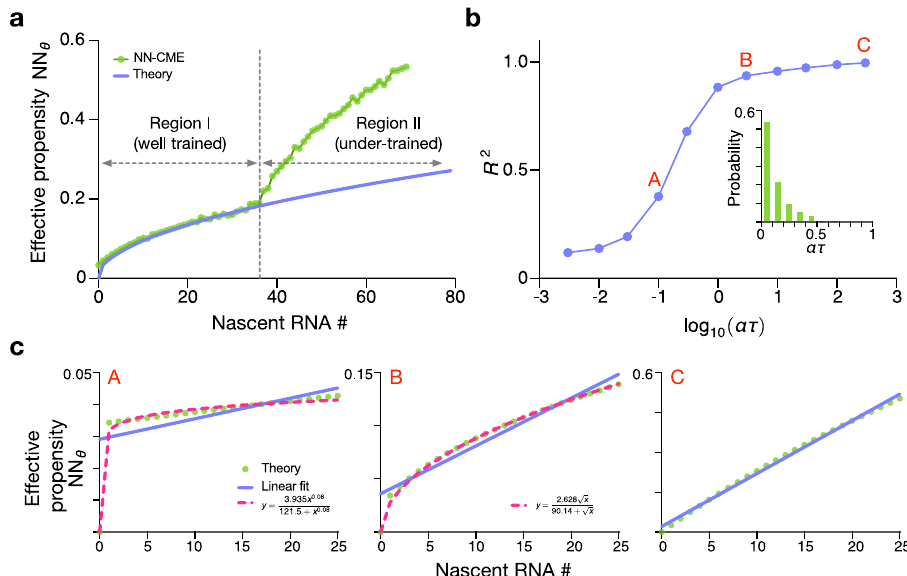
Fig. 4 Effective degradation propensity of Model II. a Comparison of the effective degradation propensity NN θ ( n ) in steady-state conditions predicted by theory (solid purple line; Eq. S36 in the SI) and computed by the ANN-aided approximation (green dots). Note that the two agree in Region I where the nascent RNA probability is suf fi ciently high so that the neural-network coef fi cients are well-trained. The two are not matched in Region II, since the neural- network coef fi cients are under trained such that the neural-network output is not reliable. b Shows the square of the Pearson correlation coef fi cient R 2 between the effective propensity and the nascent RNA number as a function of the non-dimensional parameter ατ . The non-linearity of the effective propensity rapidly increases as the burst frequency α decreases below the elongation frequency τ − 1 . Inset shows the histogram of ατ for 368 genes in mouse embryonic stem cells (see SI Note 6 for details of the histogram). c Shows the effective propensity as a function of nascent RNA numbers for points A, B and C labelled in ( b ). The function is almost independent of nascent RNA number for small ατ (point A), well-approximated by a Hill function of the nascent RNA number for intermediate ατ (point B), and a linear function of nascent RNA number for large ατ (point C). Note that the Hill function fi ts (for points A and B) are only valid over the region shown and break down for larger n . The kinetic parameters of Model II are the same as Fig. 2 and the NN- CME is trained at steady state (solving A θ ( t ) P ( t ) = 0) using 2 × 10 5